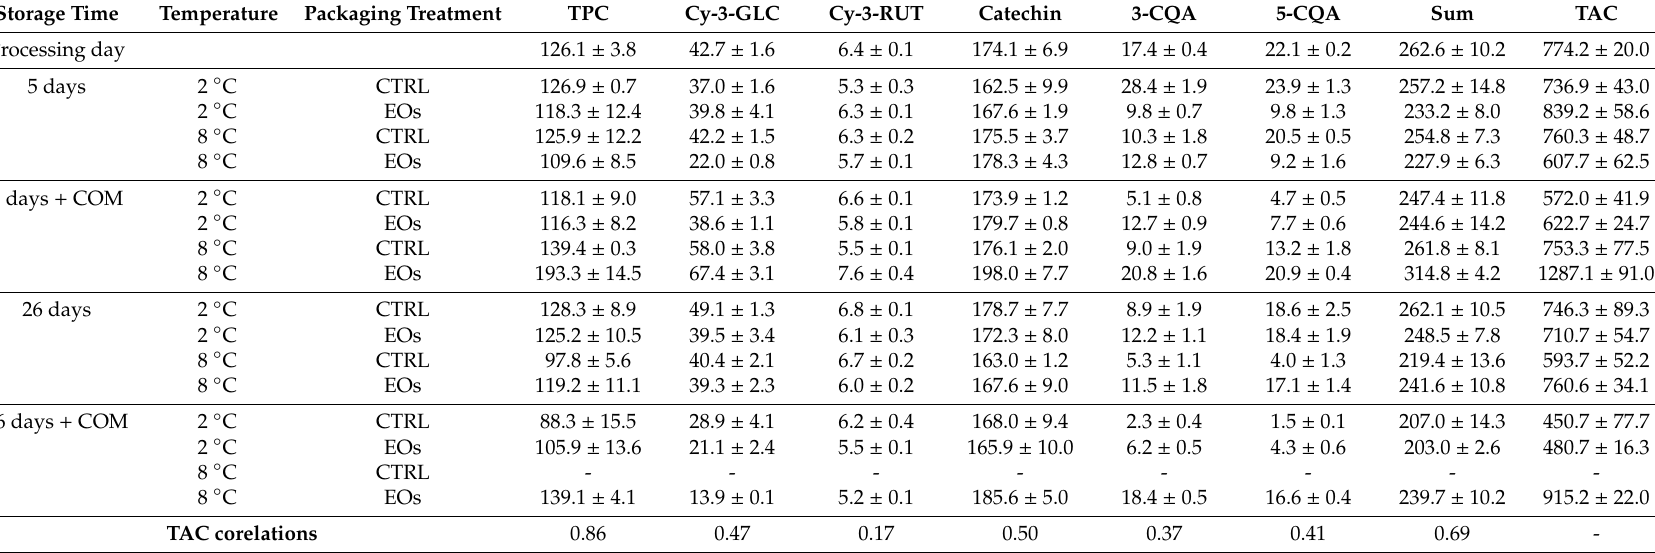
Table 3. Total phenolic content (TPC), cyanidin-3-glucoside (Cy-3-GLC), cyanidin-3-rutinoside (Cy-3-RUT), catechin, neochlorogenic acid (3-CQA), chlorogenic acid (5-CQA), sum of individual phenolic compounds, and total antioxidant capacity (TAC) values during cold storage periods (2 and 8 ◦ C) and corresponding commercialization simulations (COM; 4 days at 22 ◦ C) for flat peaches with or without active paper sheets (including β CD-encapsulated EOs) ( n = 3 ±